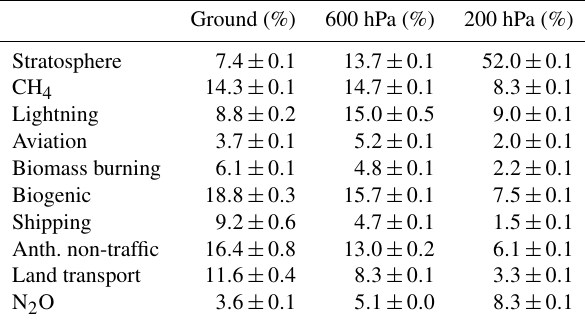
Table 8. Area-averaged contribution of different emission sources over Europe (defined as a rectangular box 10 ◦ W to 38 ◦ E and 30 to 70 ◦ N) for JJA 2008–2010 at three different altitudes (in percent). The values are mean values of the REF and EVEU simulations: the range indicates the standard deviation between the results of REF and EVEU